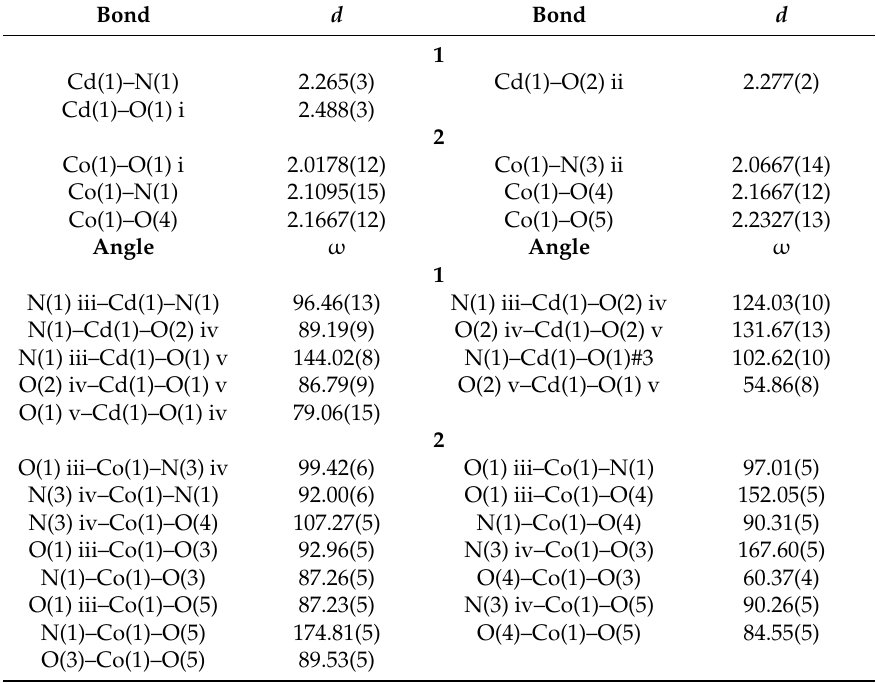
Table 1. Selected bond lengths (Å) and bond angles (°) for 1 and 2 .